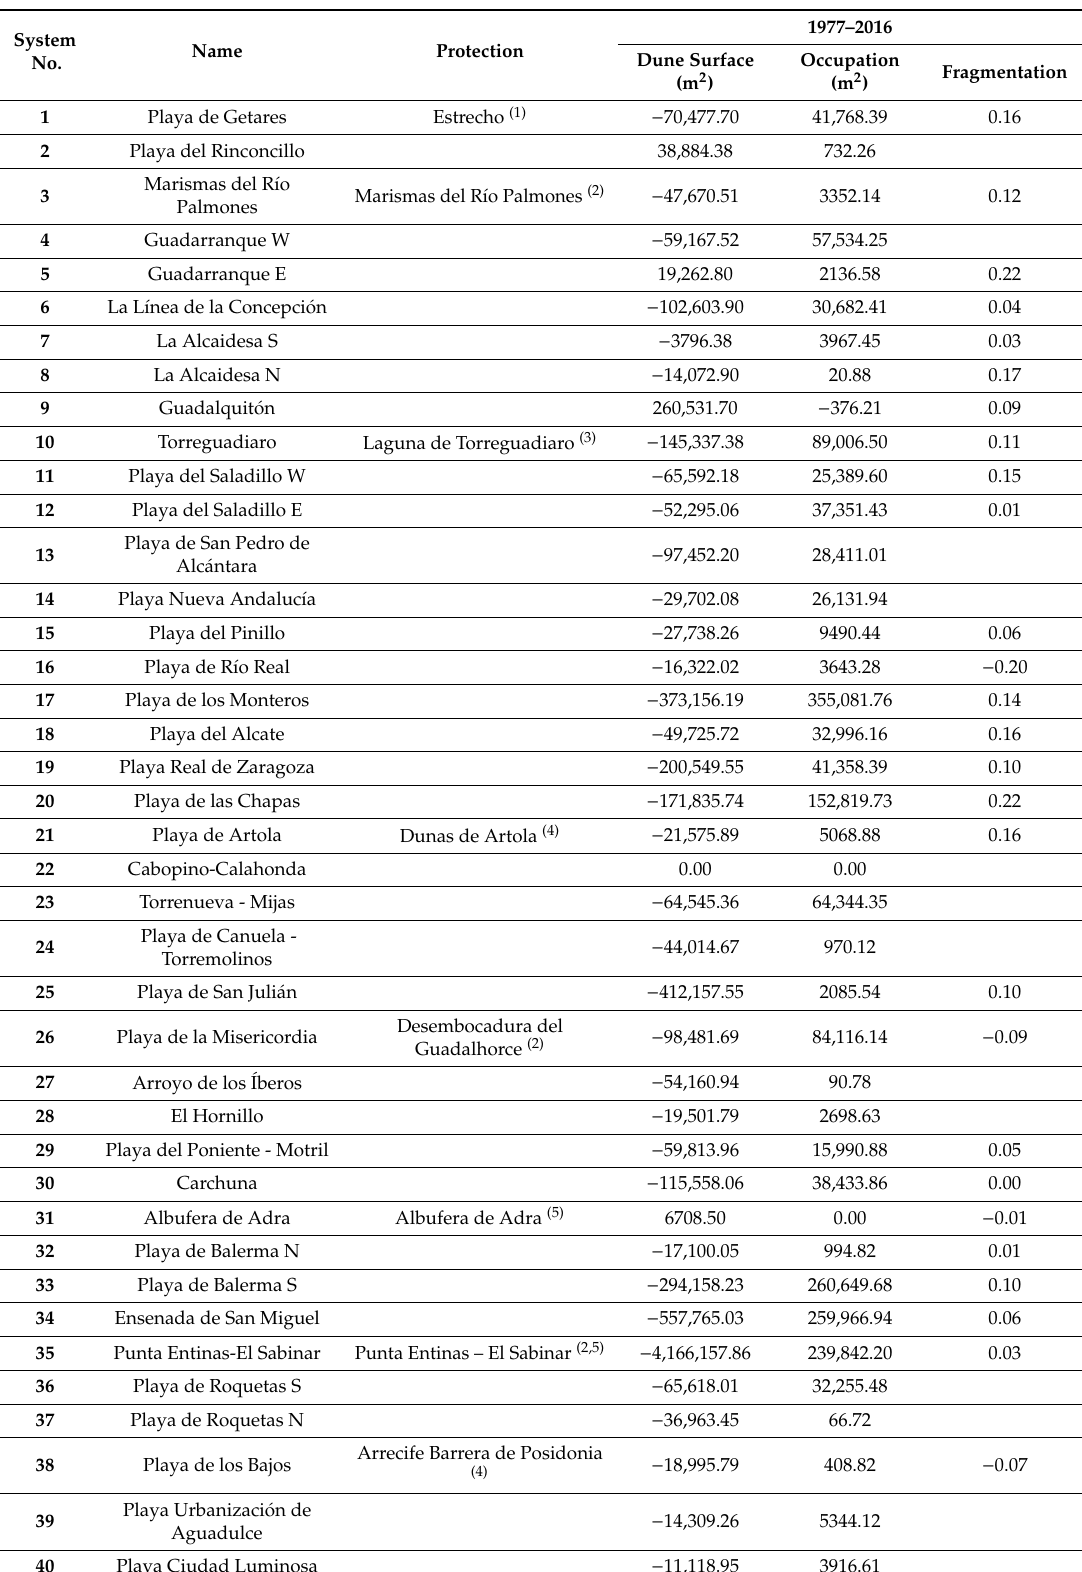
Table A1. Name and protection typology of each dune system and balance for the entire studied period. System